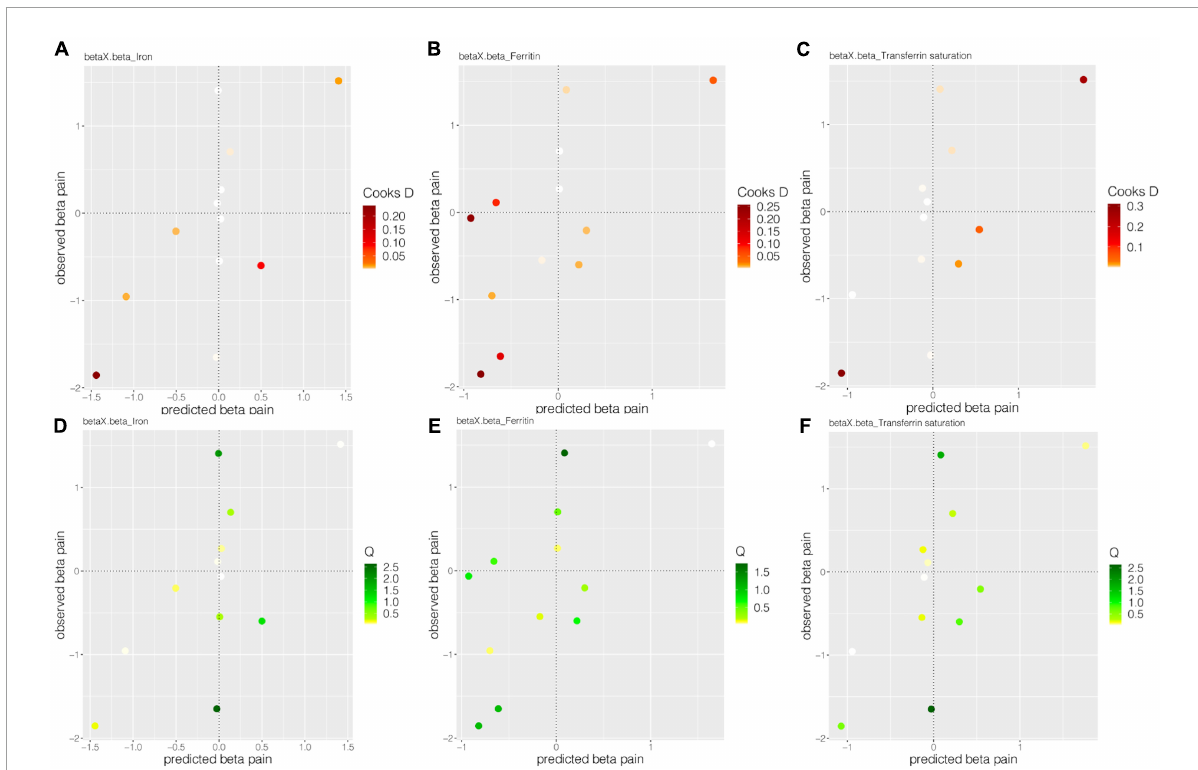
FIGURE4 The Cooks D and Q estimate systemic iron status for back pain. Panels (A–C) , respectively, showed the Cook’s distances of 12 SNPs for the effect of iron, ferritin, and transferrin saturation on back pain. Panels (D–F) , respectively, show the Q statistic of 12 SNPs for the impact of iron, ferritin, and transferrin saturation on back